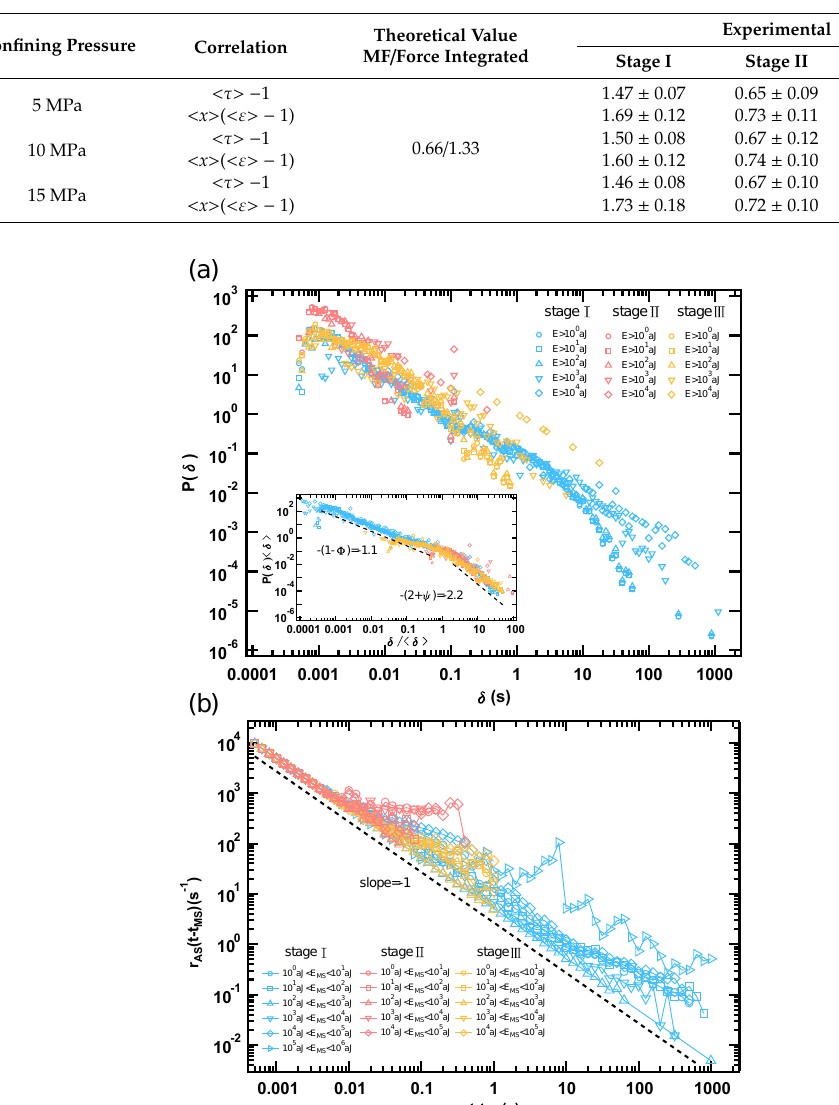
Table 2. Exponents’ scaling relationships of power law distributions for energy E , amplitude A , and the correlations with E(A) .